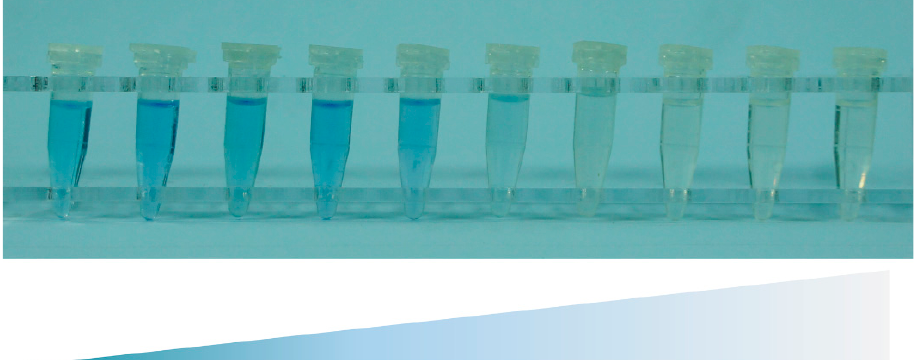
Figure 1. Change in color of the colorimetric solution. The concentrations of VX in the colorimetric solution were 0, 2, 4, 10, 40, 100, 150, 200, 400, and 500 μ g/mL, respectively, from left to right. The gradient color bar represented the VX concentration and color change of the solution.